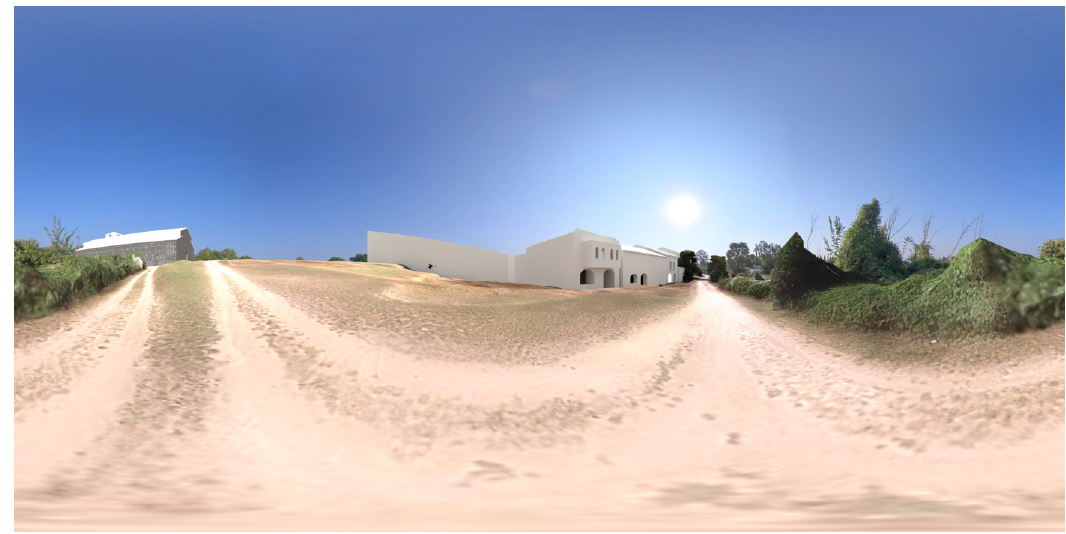
Figure 8: 3D rendering of a neighborhood of Podium Bonizi in Blender at the same position as in Figure